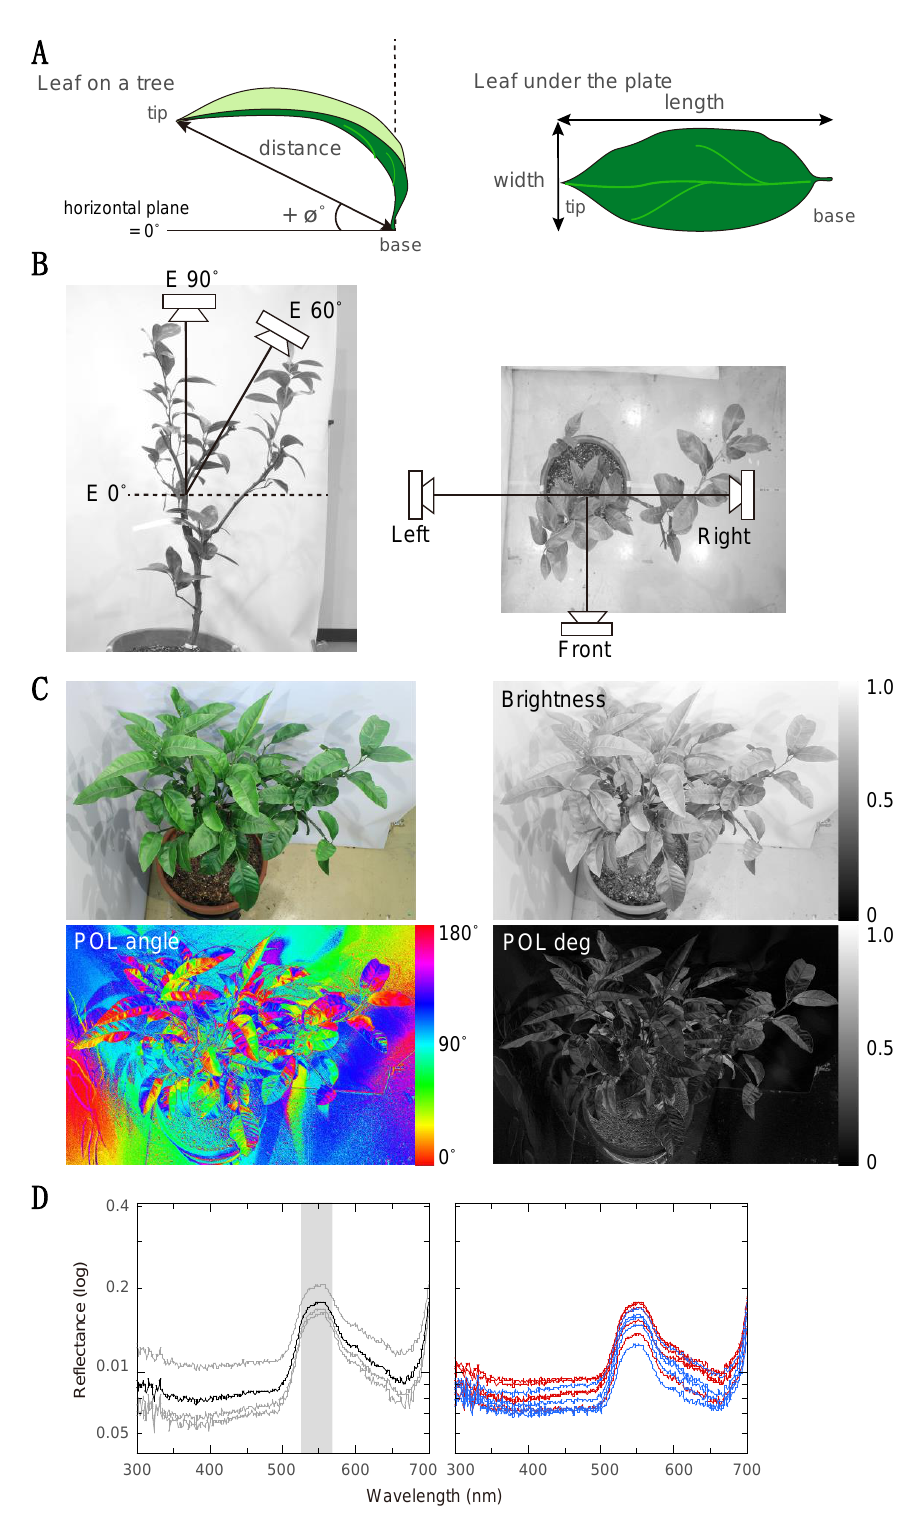
Figure 2. Morphological and reflective features of leaves. ( A ) Measurement points for orientation, flatness, and roundness. The orientation of the leaf and the distance between base and tip were measured while the leaf was on the tree (upper), then the leaf was removed from the tree and placed flat under a transparent sheet in order to measure its length and width (lower). Flatness is the ratio of distance to length; roundness is the ratio of width to length. ( B ) Positions of a camera with a polarizer for measuring brightness and polarized light information. We took photos from